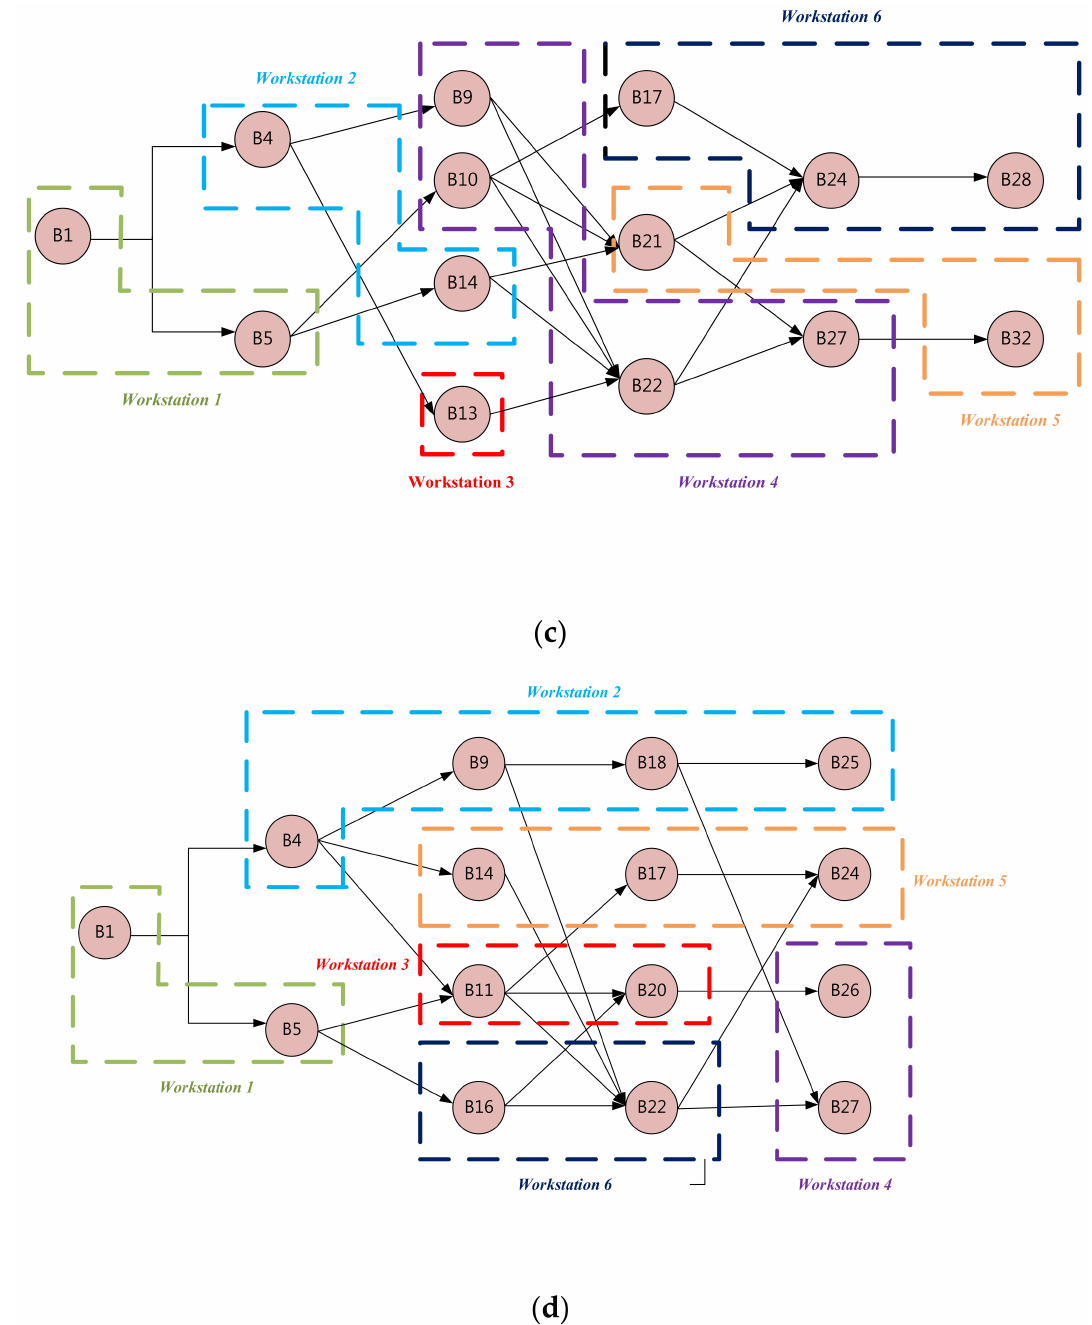
Figure 3. Disassembly diagram of the small-size test instances. ( a ) instance 1; ( b ) instance 2; ( c ) instance 3; ( d ) instance